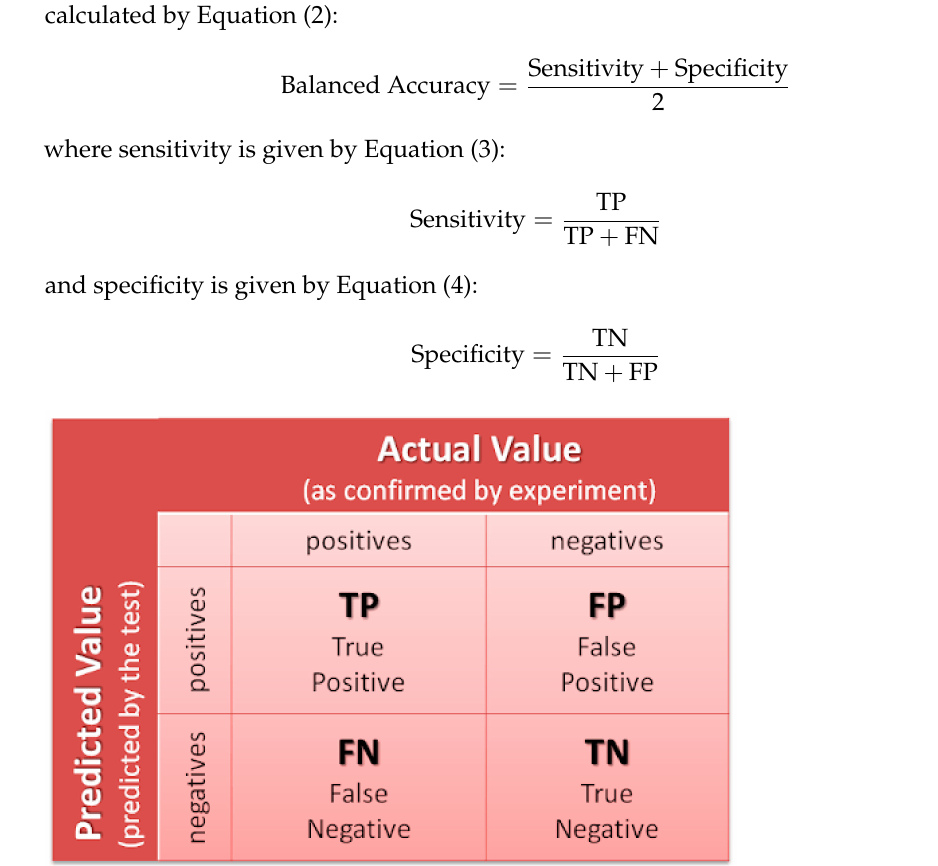
Figure 18. Confusion